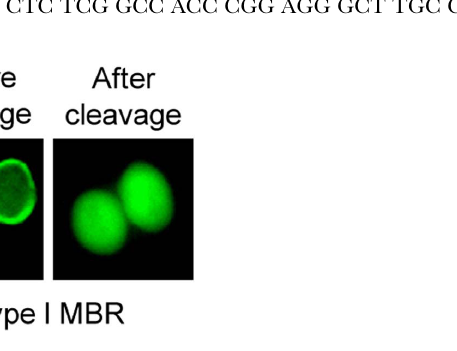
Figure 2. Detection of HCV NS3 protease using type I MBR. Before cleavage, GFP was found in the plasma membrane (ring shape, before cleavage). Cleavage of the type I MBR by HCV NS3 protease resulted in the translocation of GFP to the cytosol (dispersed image, after cleavage).